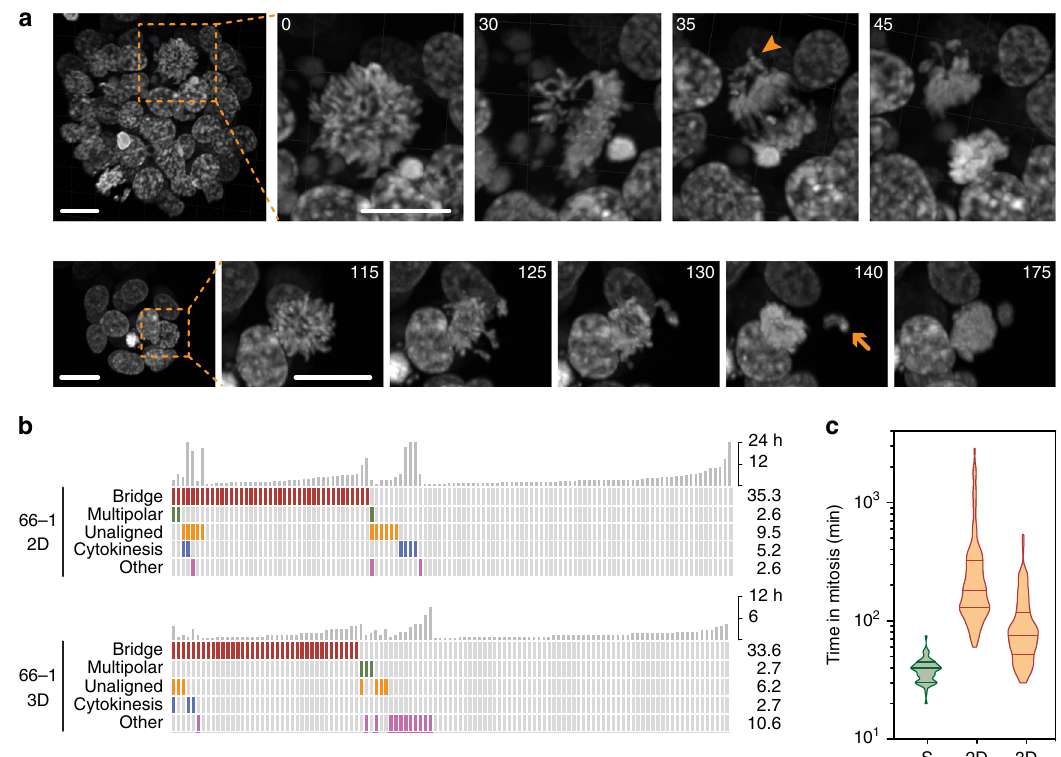
Fig. 9 Mitosis in 3D. a Z-stack projections showing examples of abnormal mitoses in OCM.66 – 1 from three biological replicates when cultured in 3D. Numbers show minutes after imaging initiated. Scale bar, 20 µ m. Arrowhead shows unaligned chromosomes at anaphase, arrow shows an ejected chromosome. b Quantitation of mitotic anomalies with each column representing one cell and the vertical grey bars representing the time each cell spent in mitosis. c Violin plot showing the time spent in mitosis for OCM.66 – 1 when cultured in 3D. Lines show the median and interquartile ranges. The 2D data from Fig. 8b is for comparison only. Source data for panels b and c are provided as a Source Data fi